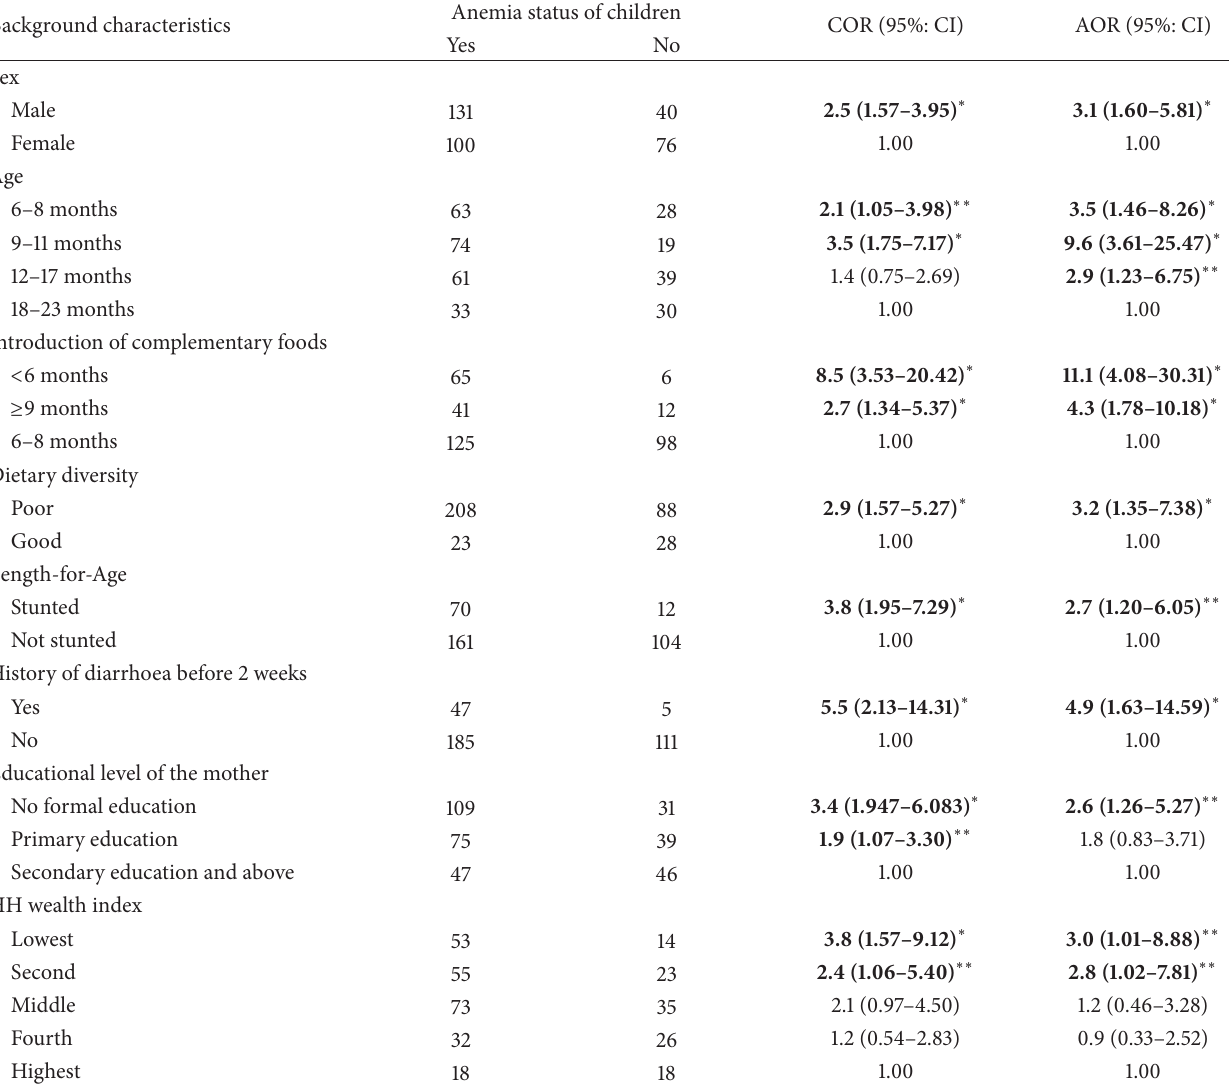
Table 4: Factors associated with anemia among children aged 6–23 months attending growth monitoring clinic at Tsitsika Health Center, Northeast Ethiopia, ( 𝑛 = 347